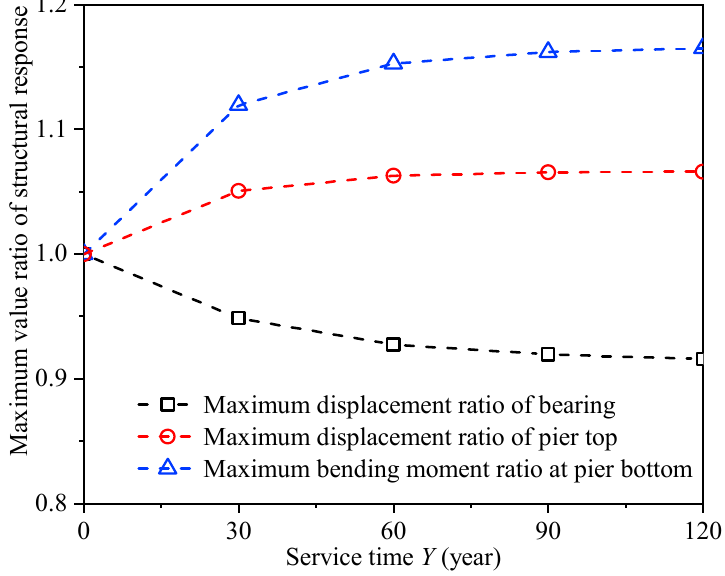
Figure 22. Maximum value ratio of structural response.